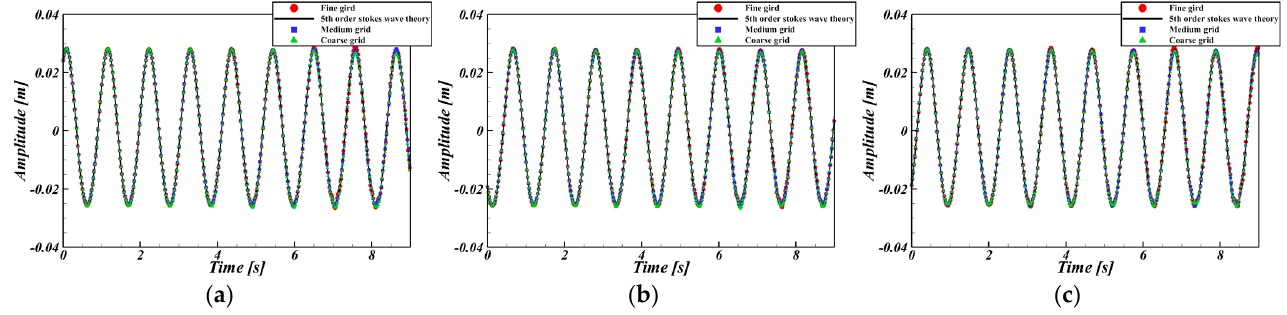
Figure 12. Comparison of wave profiles at λ = 1.800 m: ( a ) x = + 1.650 m from the origin; ( b ) x = + 0.675 m from the origin; ( c ) x = − 0.675 m from the origin.